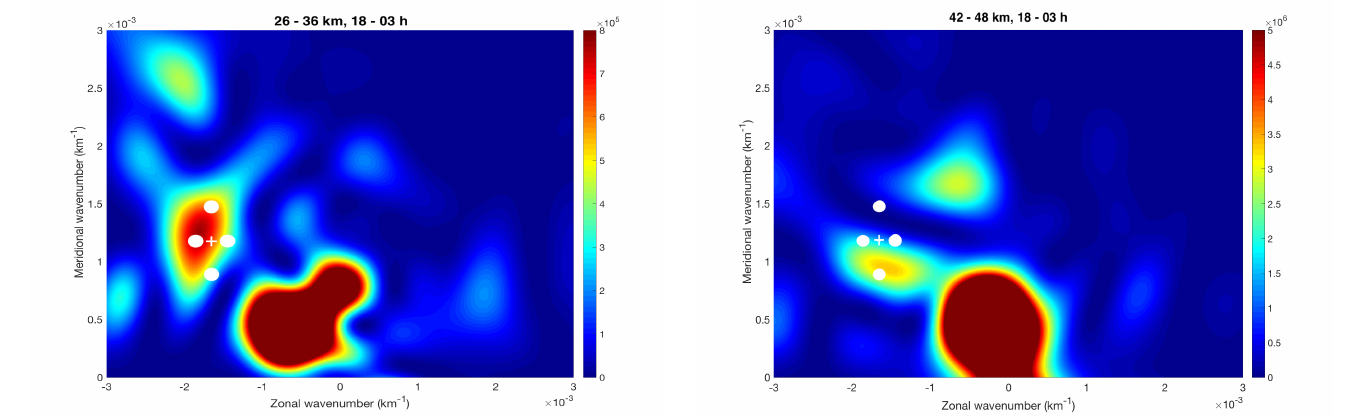
Figure 8. Left : Average 2D Fourier spectrum of ERA 5 temperature fields for the altitude range 26–36 km ( left ) and 42–48 km ( right ) for the time range [18 p.m. 03 a.m.]. The white crosses represent the wavenumbers estimated using the OH keograms. The crosses are the estimated errors on the wavenumbers, calculated directly from the error on the slope of the linear fit (Figure